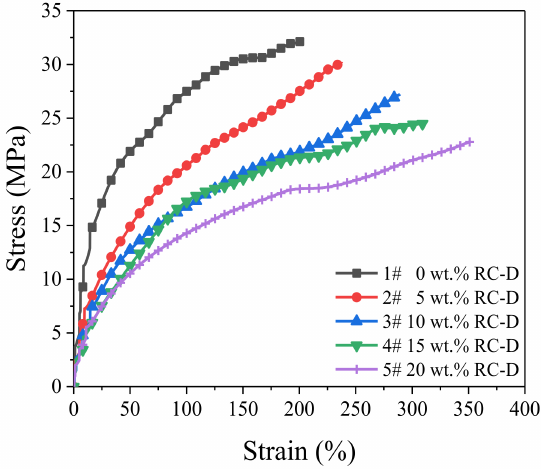
Figure 9. The stress–strain curves of five polymer-based paint films.